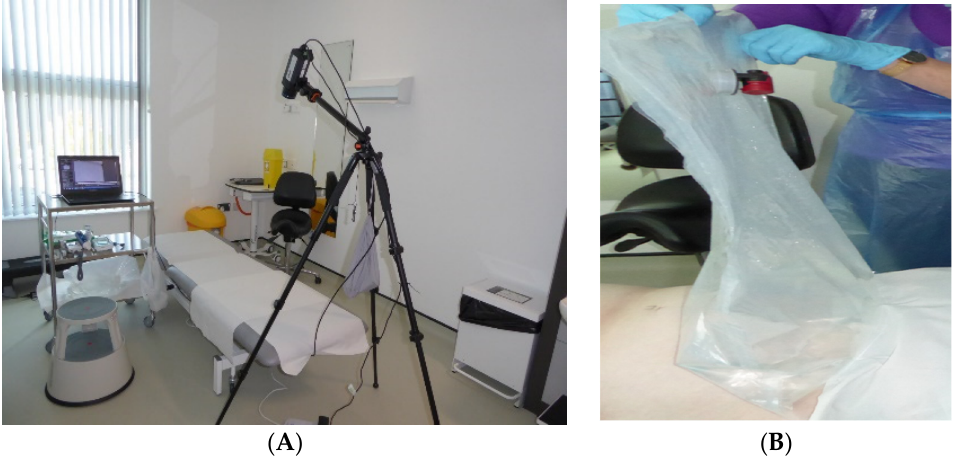
Figure 2. Clinical set up, ( A ) Tripod mounted thermal imaging detector positioned over examina- tion couch for Field of View to include abdomen. ( B ) Water-filled bag at 18–20 °C applied to abdo- men to induce local thermal challenge